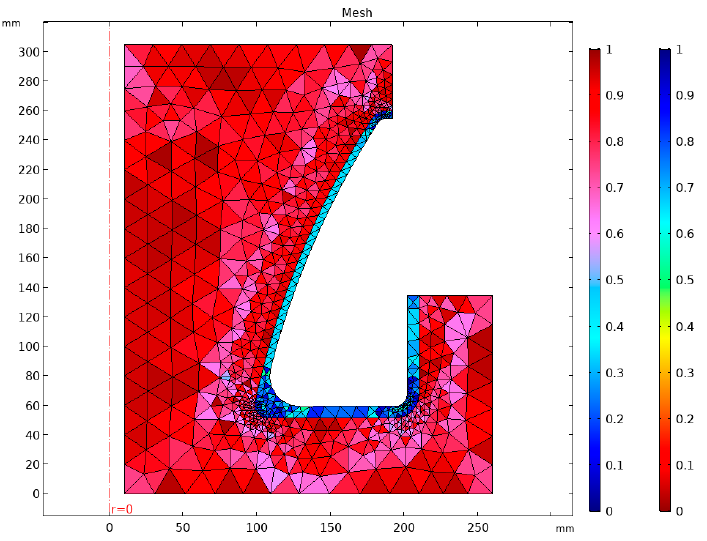
Figure 2. Used FE mesh in 3D thermal model and element quality; mould in red and part in blue.